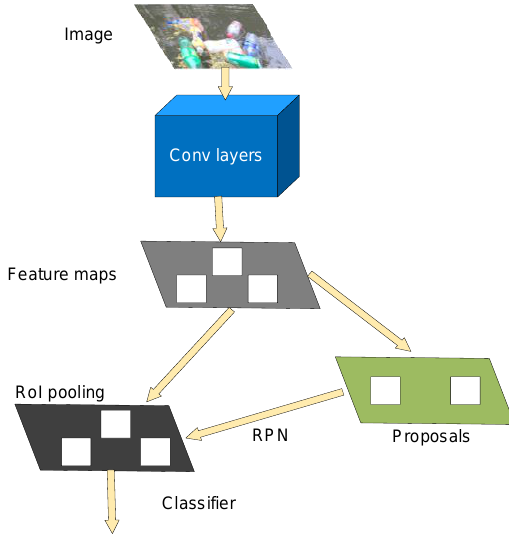
Figure 6. The Faster R-CNN model.